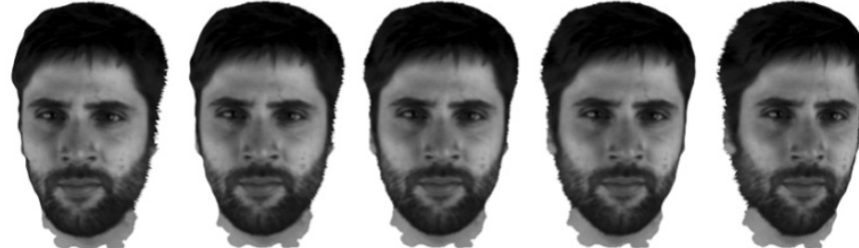
Figure 20. Example head views generated for printing.